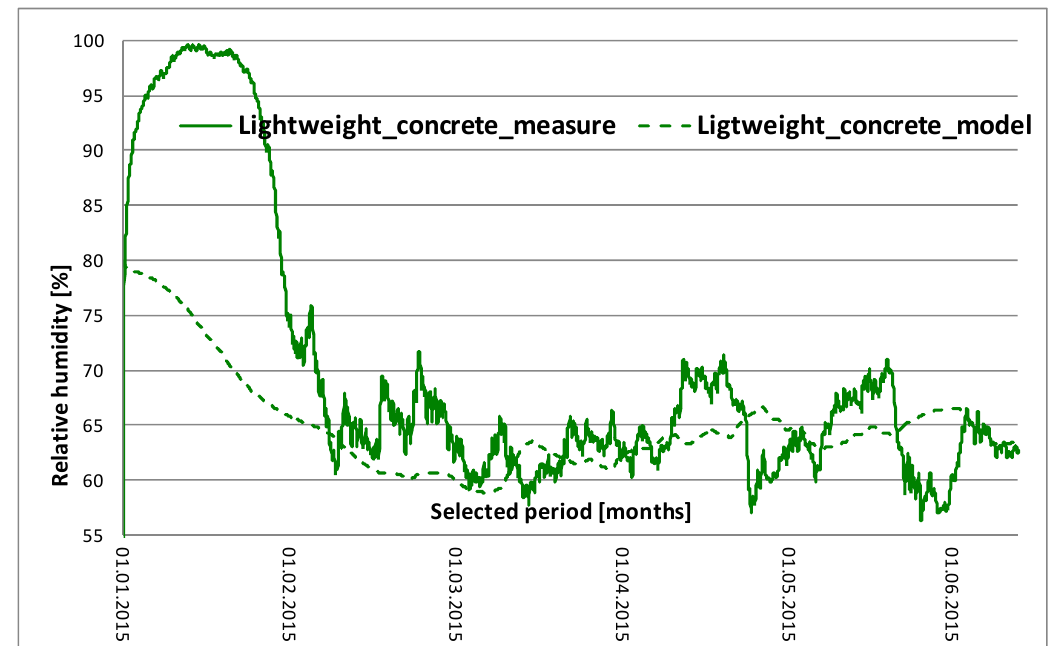
Figure 8. Temperature profile for the selected measurement places of the envelope. Collected results of the measurements and numerical modeling (description in the text).